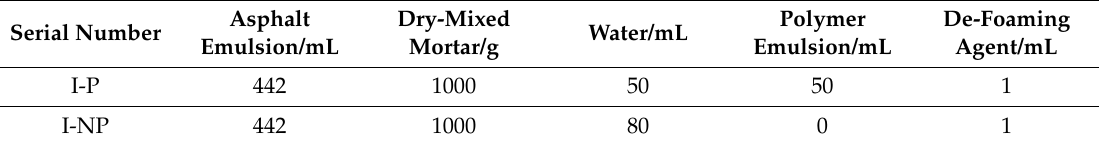
Figure 1. Preparation of the CA mortar. Table 3. Mix proportion of the CA mortar used in CRTS I ballastless slab track.